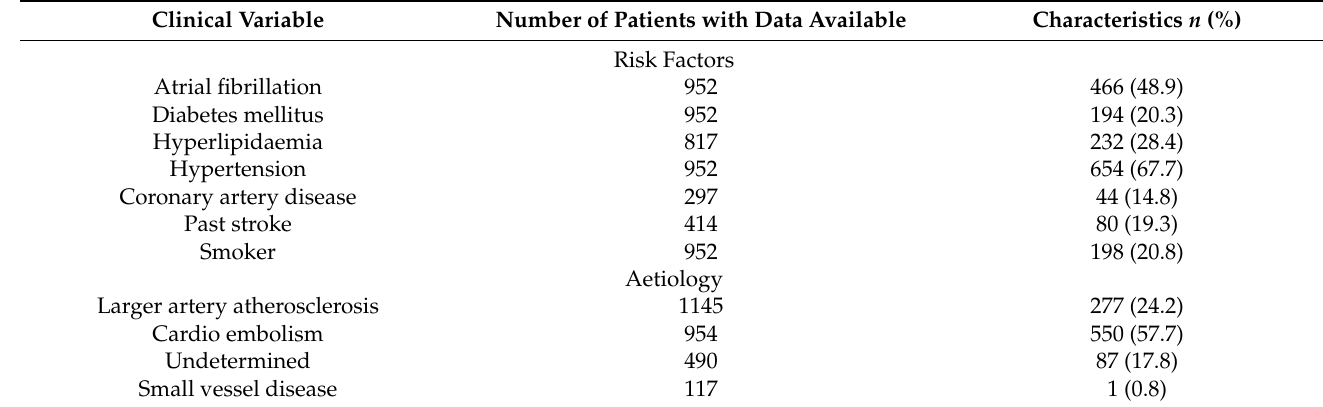
Table 2. Overall summary of the prevalence of risk factors and stroke aetiologies in the meta-analysis.